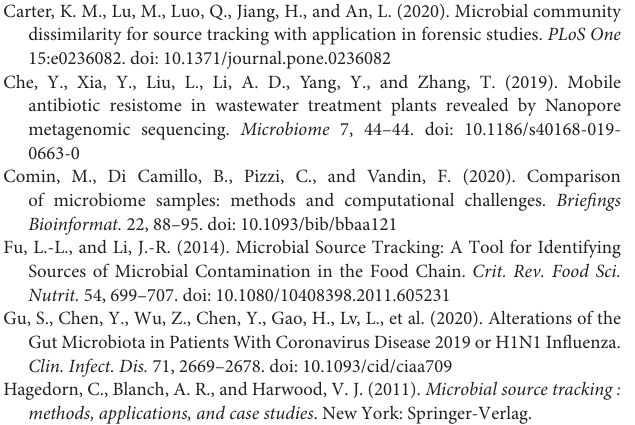
Supplementary Table 1 | Samples used in assessment of different methods on a standard benchmark